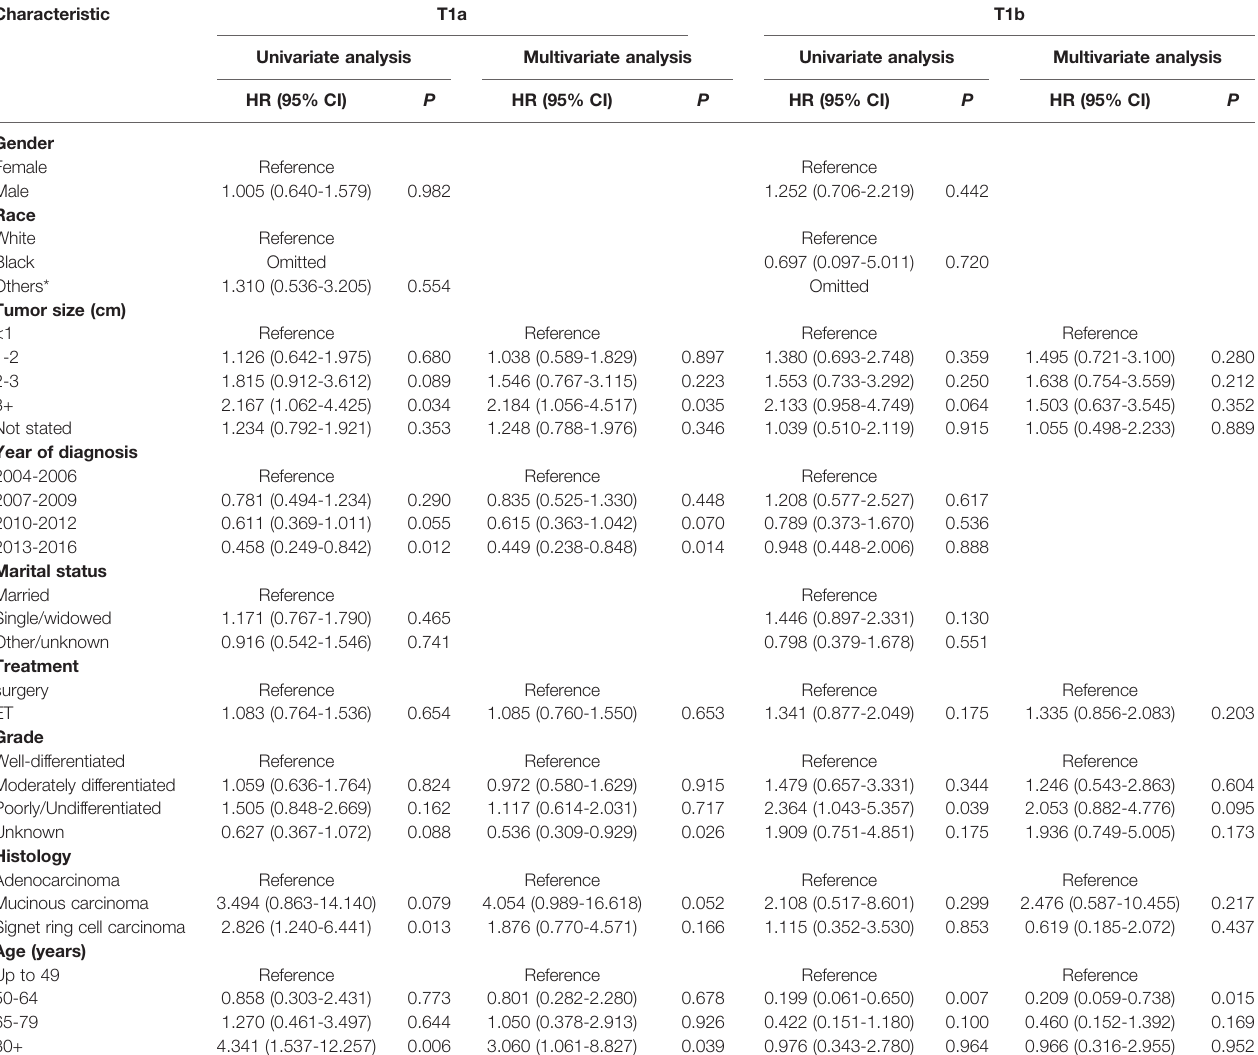
TABLE 6 | Cox regression analysis of CSS in patients with T1a and T1b esophagogastric junction cancer after propensity score matching. Characteristic